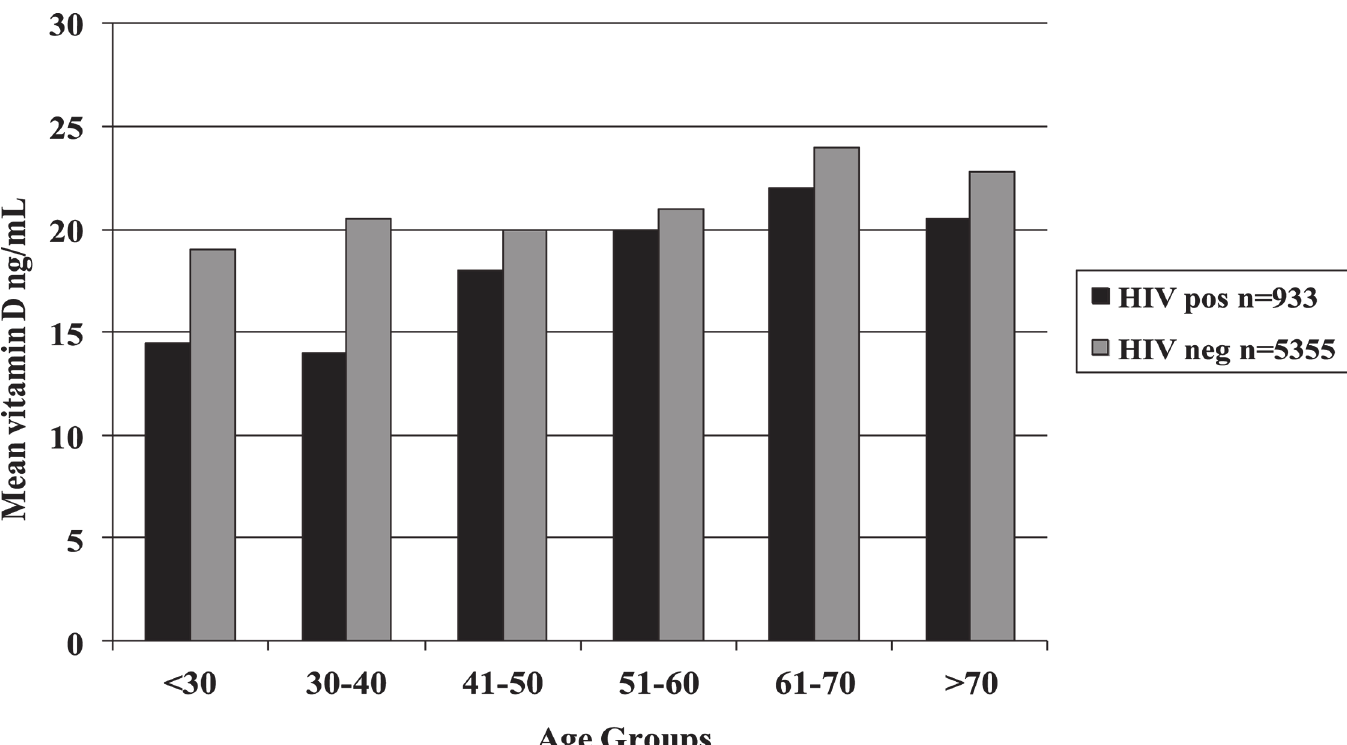
Fig 1. Mean Vitamin D Level by Age Group for HIV positive and HIV negative Patients.